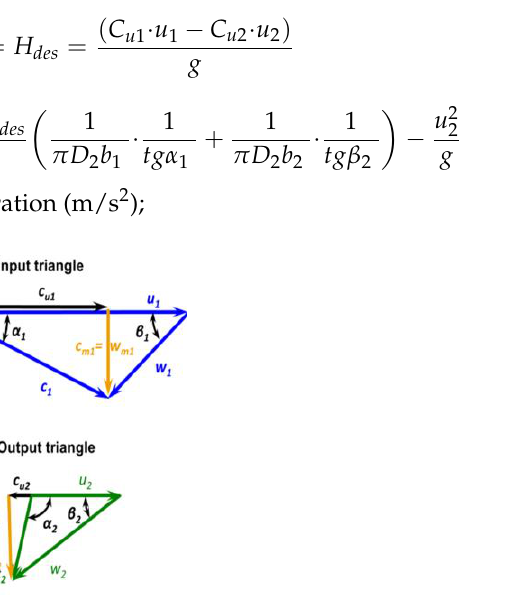
Figure 1. Typical correlation diagram between specific speed ( n q ) and head ( H ) [29]. A combination of specific values for Q (m 3 /s), N (rpm) and H (m) determines the so-called “design point” or Best Efficiency Point (BEP) of the hydro-turbine, i.e., the point where the hydro-turbine is designed to operate at its highest efficiency. Euler’s fundamental equation for turbines relates the power absorbed from the water flow with the geometry and the velocities of the runner. Its general formulation is presented in Equation (2a). By rearranging Equation (2a) by means of introducing the geometrical properties of the runner, its mathematical formula shapes into Equation (2b). Equation (2b) applies to all reaction type turbines and becomes more accurate when blade thickness can be assumed negligible when compared with the annulus passage area over the entire blade zone [30]. The schematic representation of the velocity triangles at turbine inlet and outlet, along with the notation of the various velocity components and angles that are employed in Equation (2) are depicted in Figure 2.